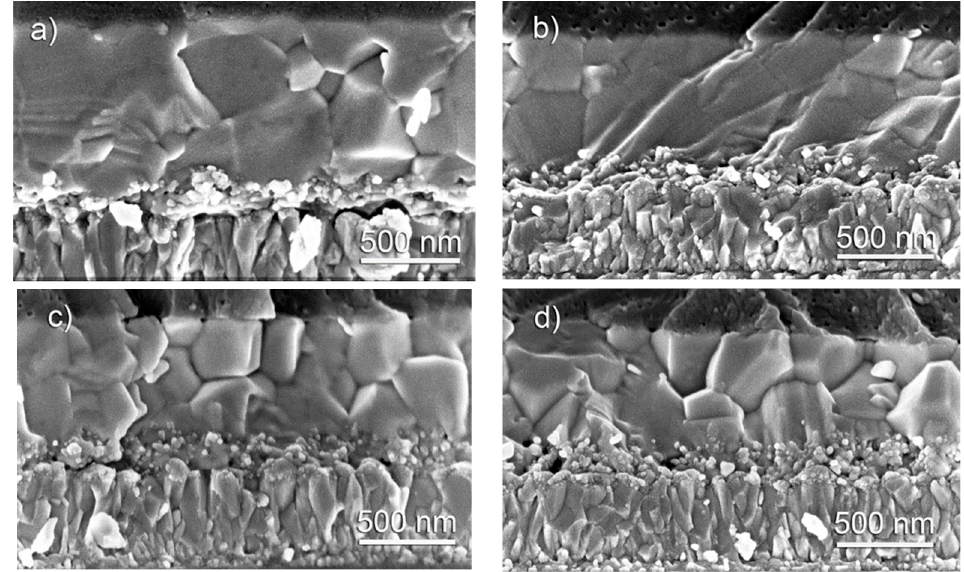
Figure 4. Cross-sectional SEM images of perovskite cells formed on fluorine-doped tin oxide (FTO) substrate with ( a ) 0, ( b ) 5, ( c ) 10, and ( d ) 15 % Cs. Magnification is